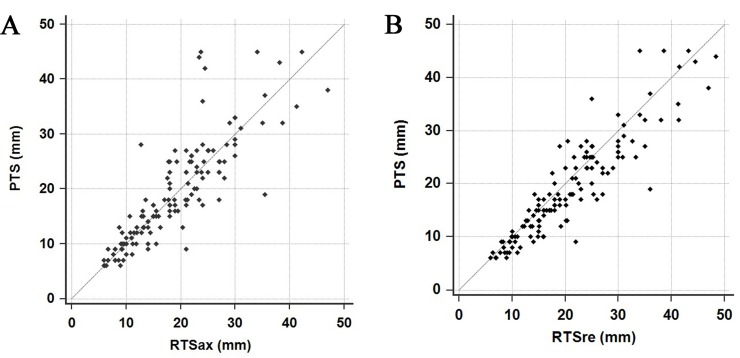
Scatter plots of pathological tumor size (PTS) vs. radiologic tumor size (RTS).(A) The relationship between PTS and RTS measured on axial images (r2 = 0.719, p<0.001). (B) The relationship between PTS and RTS measured on reconstructed multiplanar images (r2 = 0.833, p<0.001).